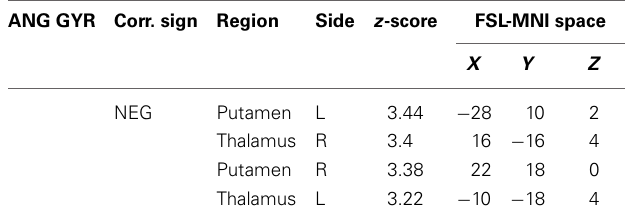
FIGURE 5 | Effect of impulsivity score in functional connectivity group maps. In blue-light color scale are displayed anti-correlating. In the left column is displayed the negative functional connectivity GM- of angular gyrus with the rest of the brain. In the right column are displayed the connectivity maps of the same AG cluster after inserting the participants impulsivity Scale scores in the GLM (IC-GM). Table 3 | Additional areas functionally connected with angular gyrus after correction for impulsivity.